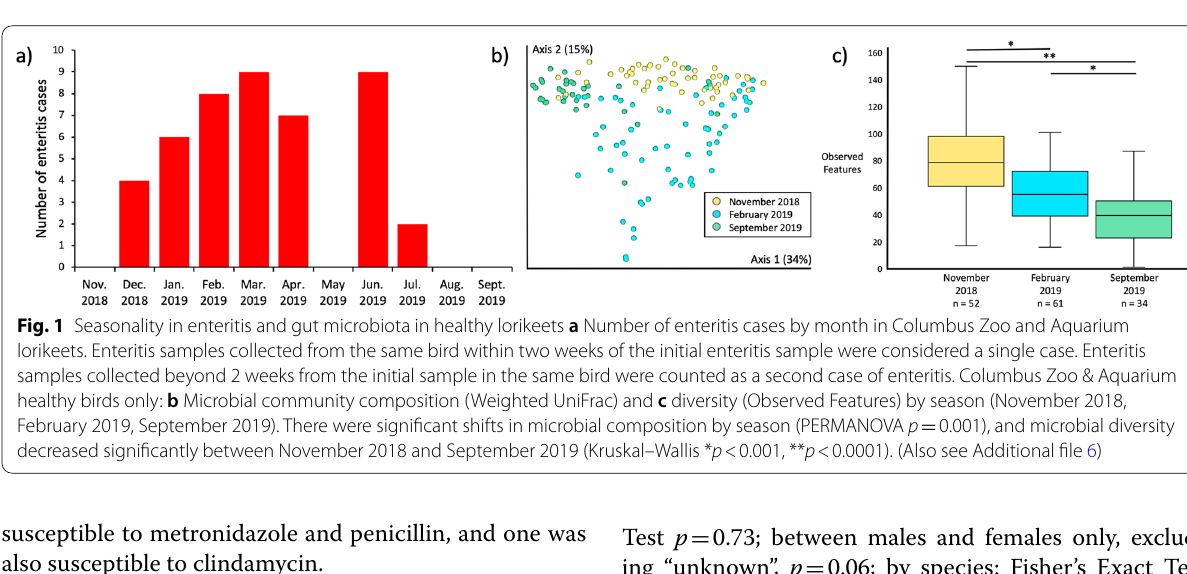
0.001), and microbial diversity =